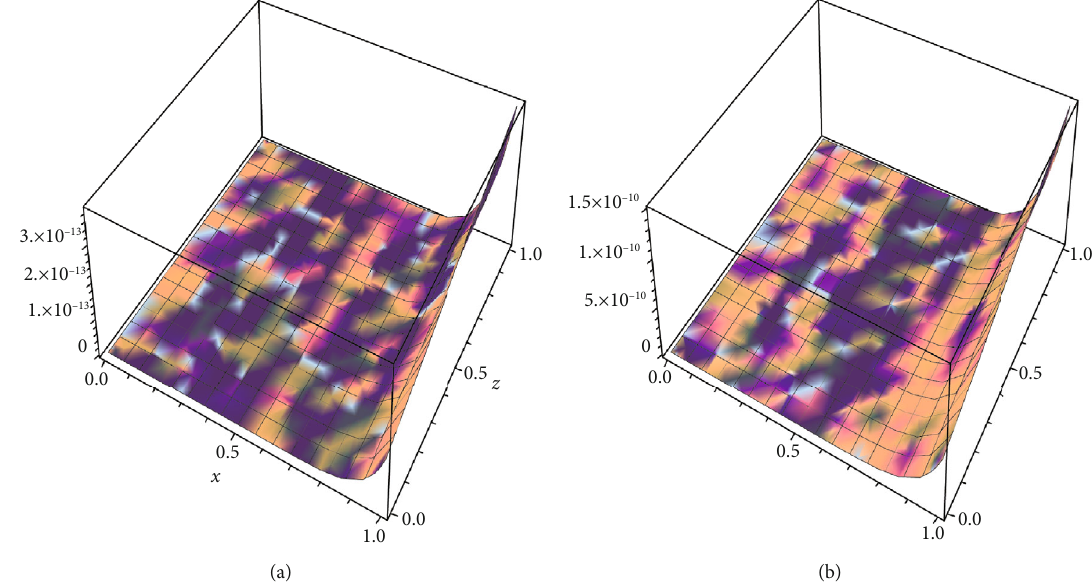
Figure 4: The absolute error between exact solution and tenth-order approximate solution: ð a Þ α = 1 : 4 and ð b Þ α = 1 : 2 .